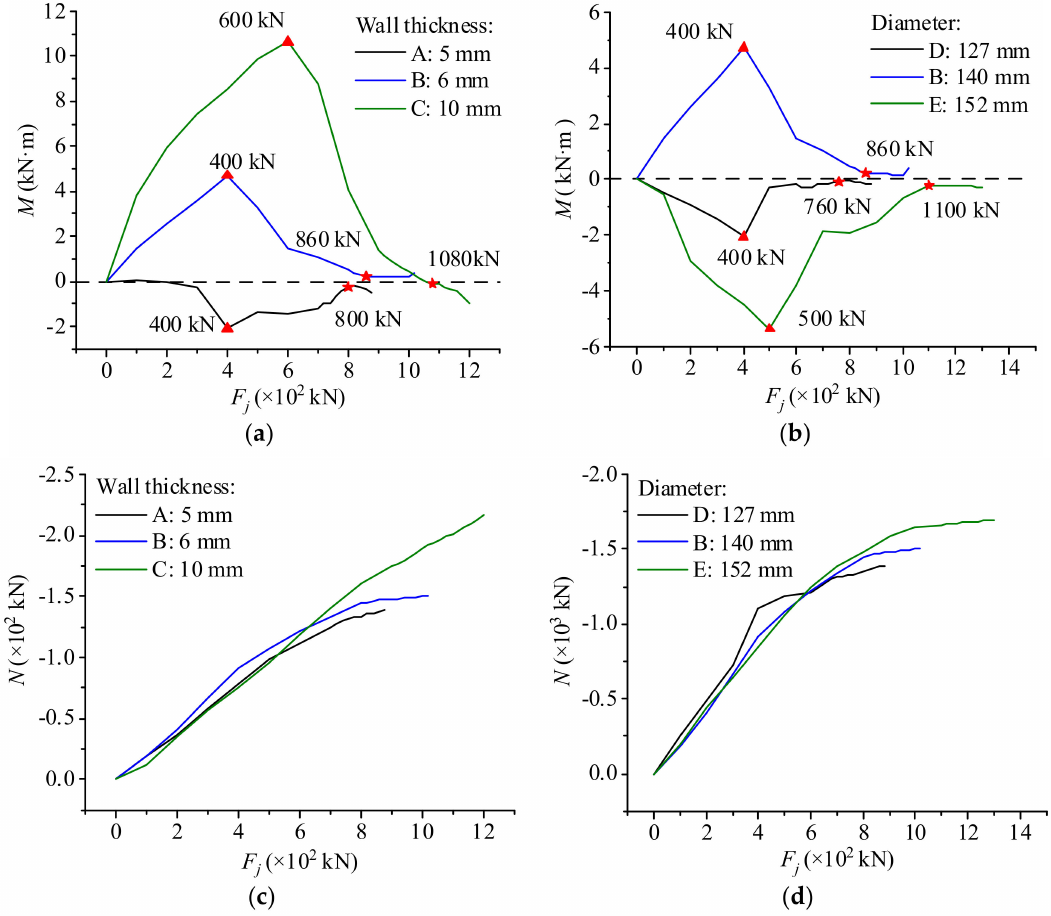
Figure 12. The internal forces of the di ff erent supports: ( a ) The in-plane bending moments of the supports with di ff erent wall thickness; ( b ) the in-plane bending moments of the supports with di ff erent diameter; ( c ) the axial forces of the supports with di ff erent wall thickness; ( d ) the axial forces of the supports with di ff erent